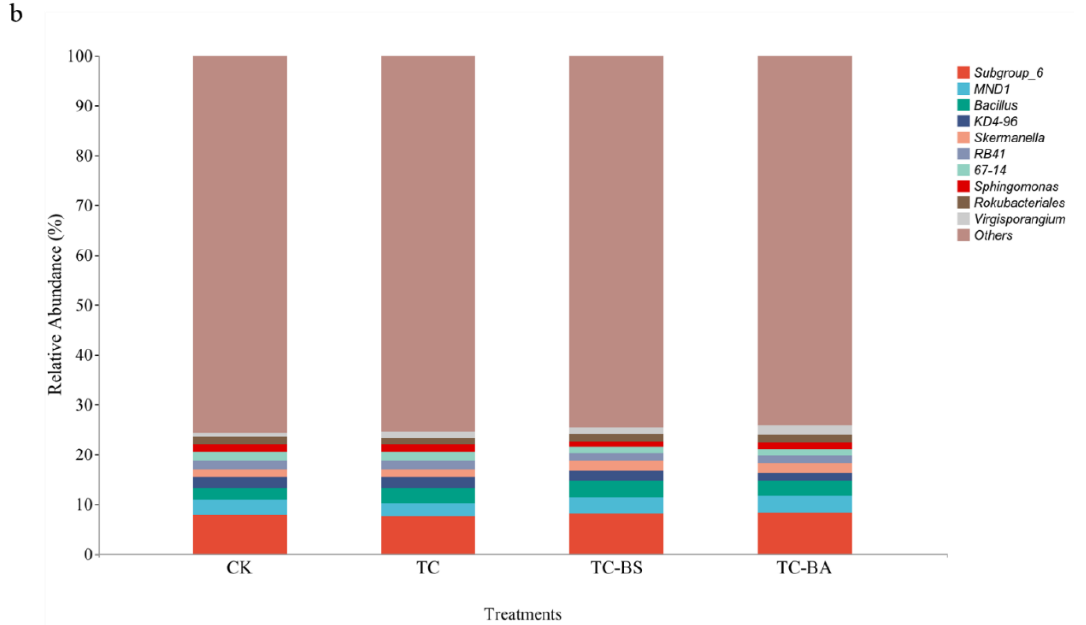
Figure 3. Relative abundance of soil bacteria in ginger field at the phylum and genus level. [( a ) for phylum level; ( b ) for genus level]. CK: no tomato plant residue compost or PGPR; TC: tomato plant residue compost; TC-BS: tomato plant residue compost + B. subtilis ; TC-BA: tomato plant residue compost + B. amyloliquefaciens SQR9.